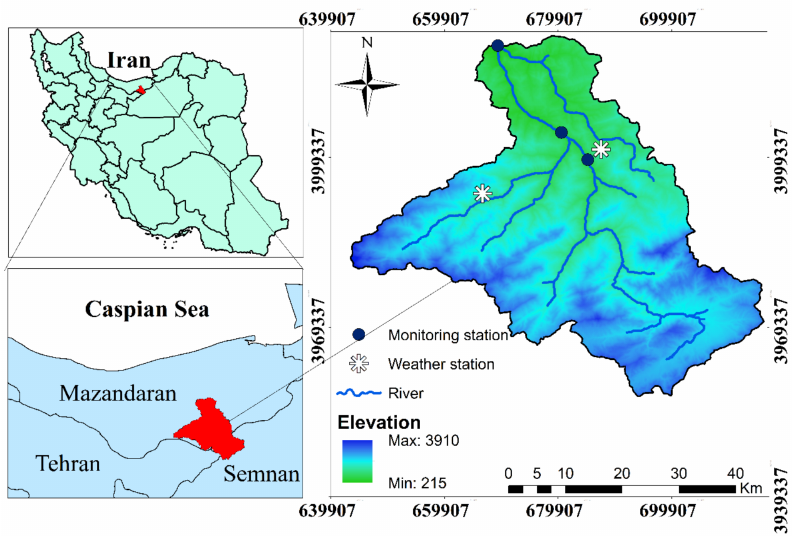
Figure 1. Location of Talar